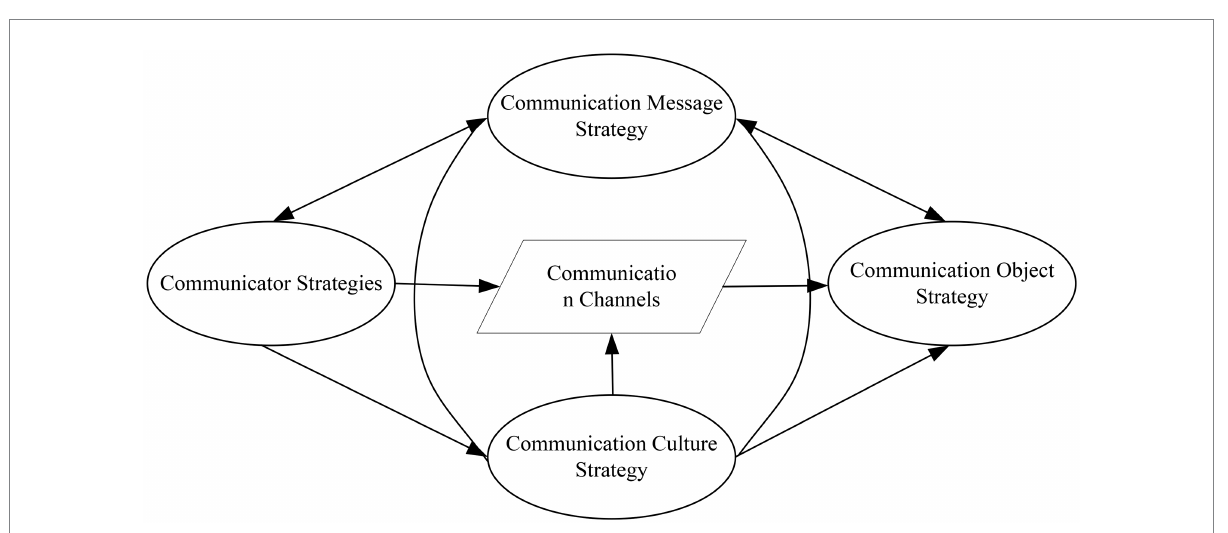
FIGURE 5 Five strategies for effective